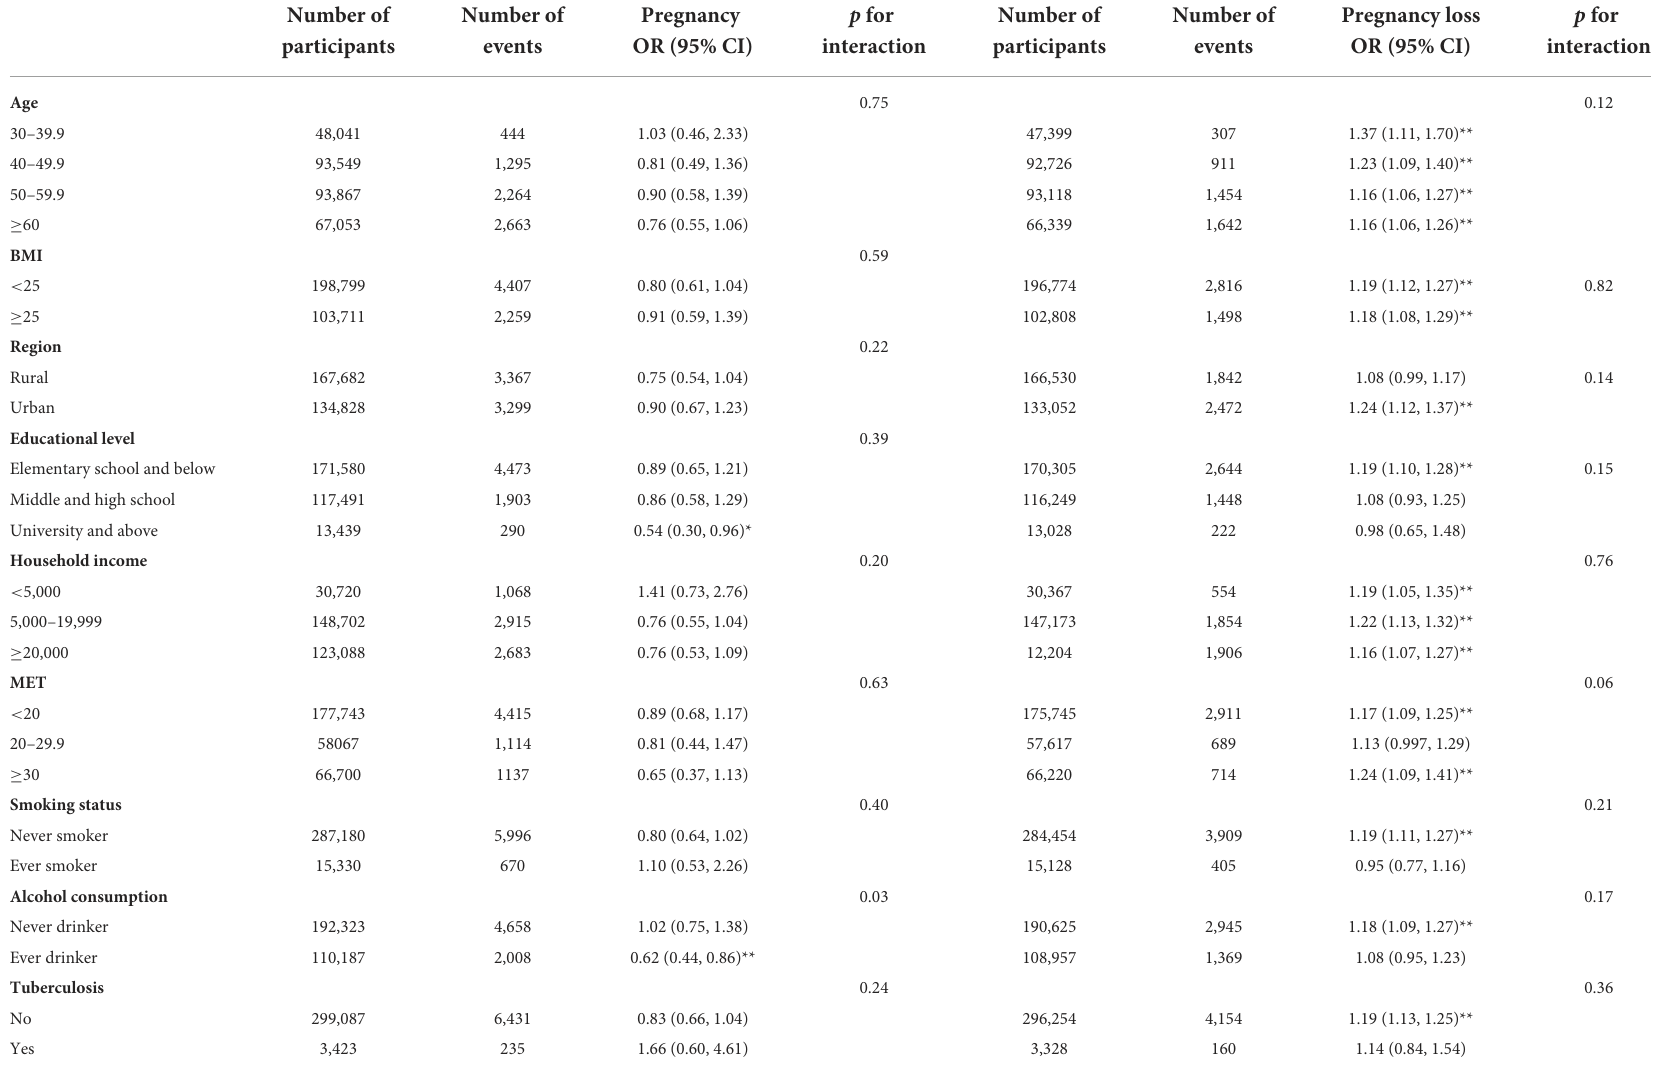
TABLE 3 Adjusted odds ratios (95% confidence intervals) for COPD risk associated with number of pregnancies and pregnancy losses, stratified by baseline